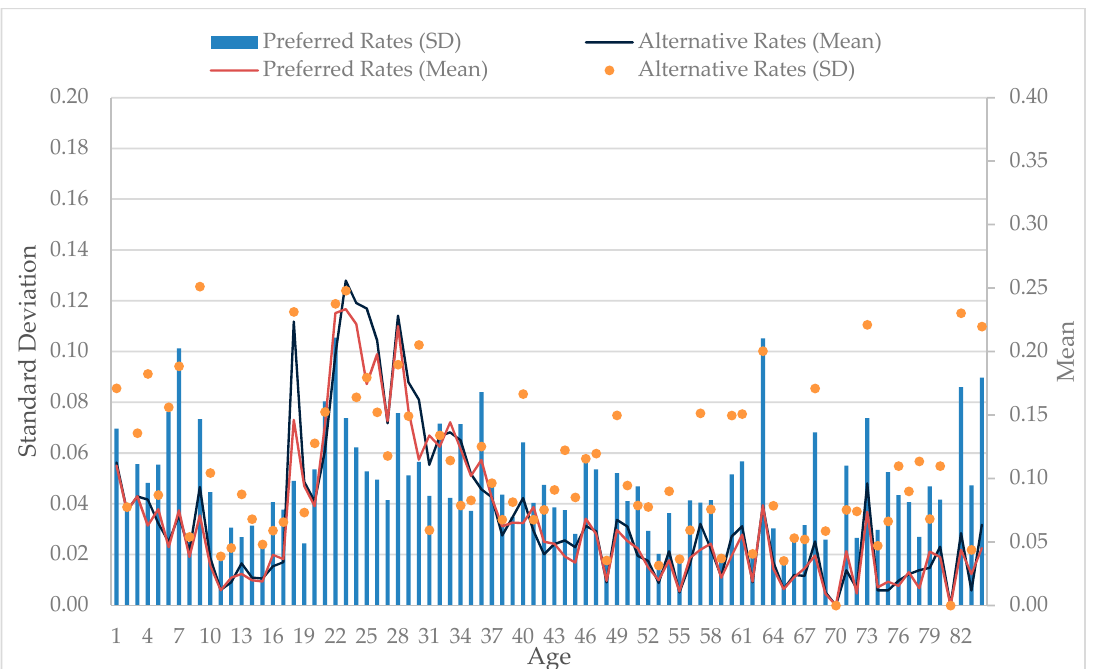
Figure 2. Means and Standard Deviations of Female Domestic Out-Migration Rates, 2007–2014. Source: 2006–2014 1-Year American Community Survey.